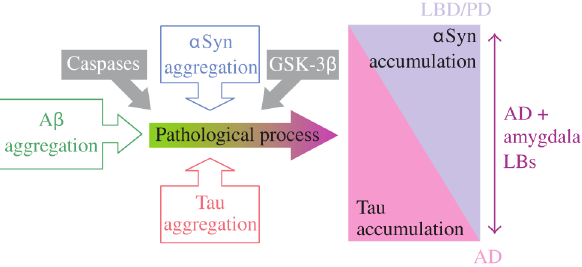
FIGURE 1: Hypothetic diagram unifying pathologic processes in Alzheimer and Lewy body diseases. PD: Parkinson disease; LBD: Lewy body disease; LBs: Lewy bodies; AD: Alzheimer disease.